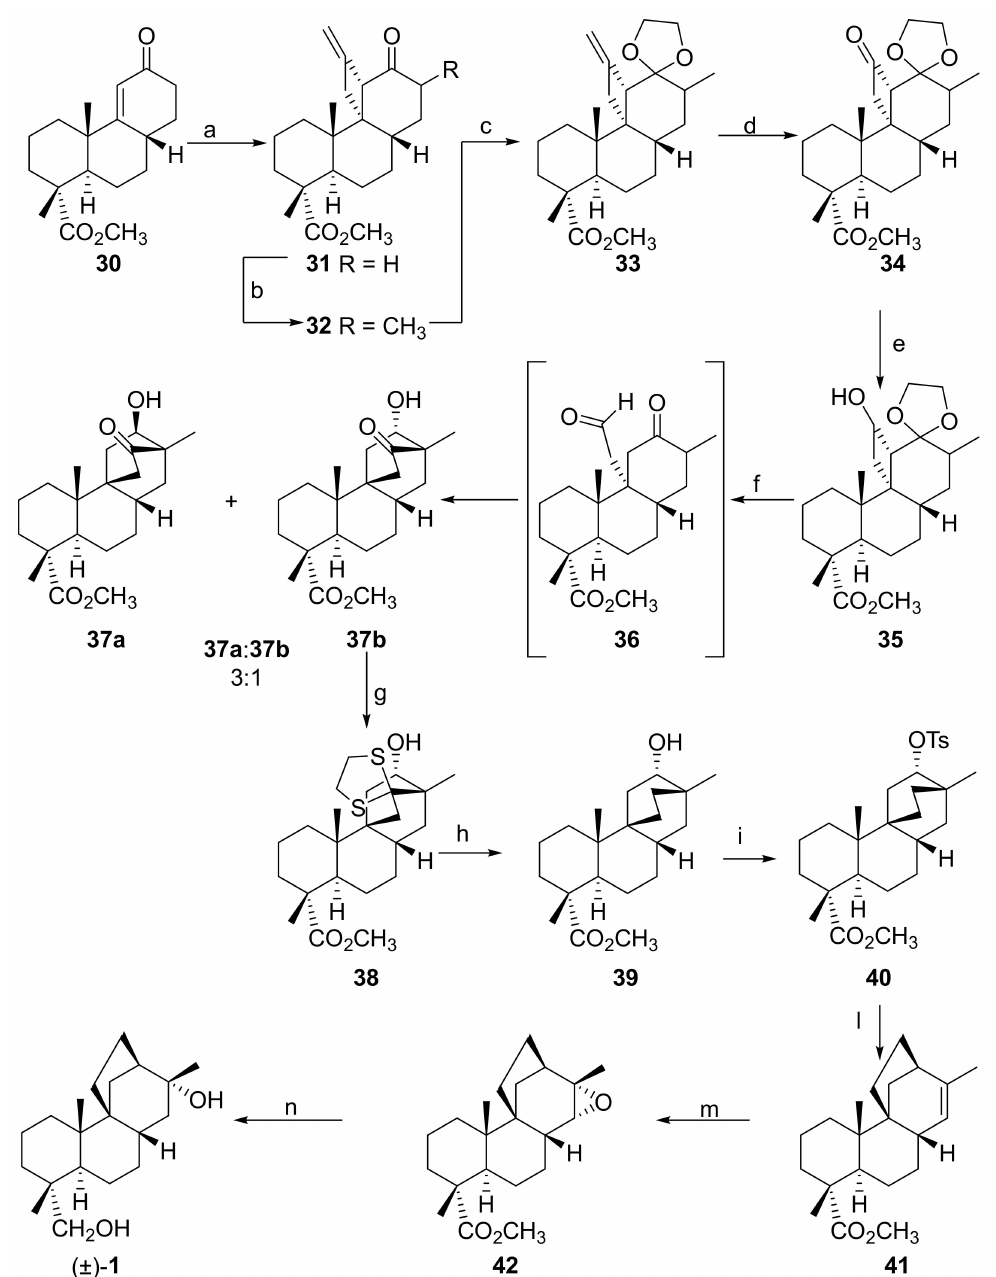
Scheme 4. Schematic representation of ( ± )-stemarin 1 synthesis by Kelly and coworkers. Reagents and conditions: ( a ) allene, h ν (Photochemical reaction), − 78 ◦ C; ( b ) THF (Tetrahydrofuran), − 10 ◦